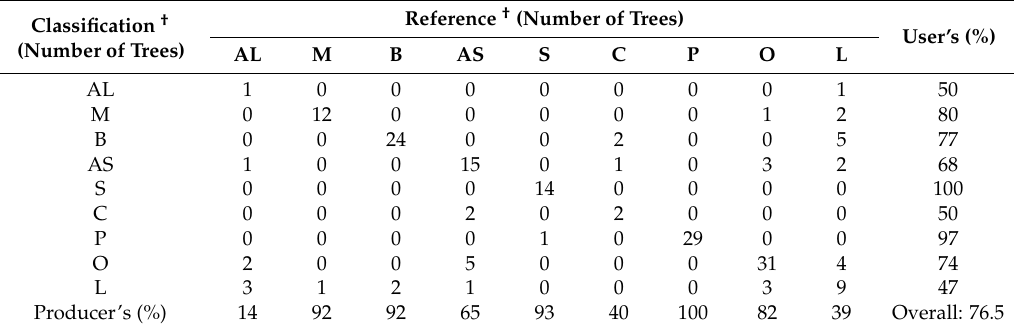
Table 6. Confusion matrix for the best performing model (features used are: P C 1 Q C 2 , Q C 3 and Q C 3 ). 95 90 01